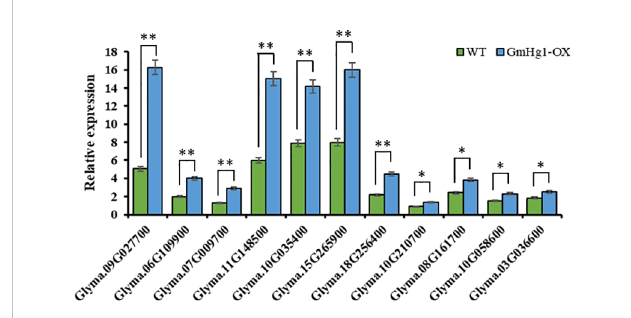
FIGURE 9 Analysis of the expression pattern of genes in the co-expression network. Asterisks indicate a signi fi cant difference compared with the corresponding controls (Student ’ s t -test: ** p < 0.01). Values represent the means of three biological replicates. *p <